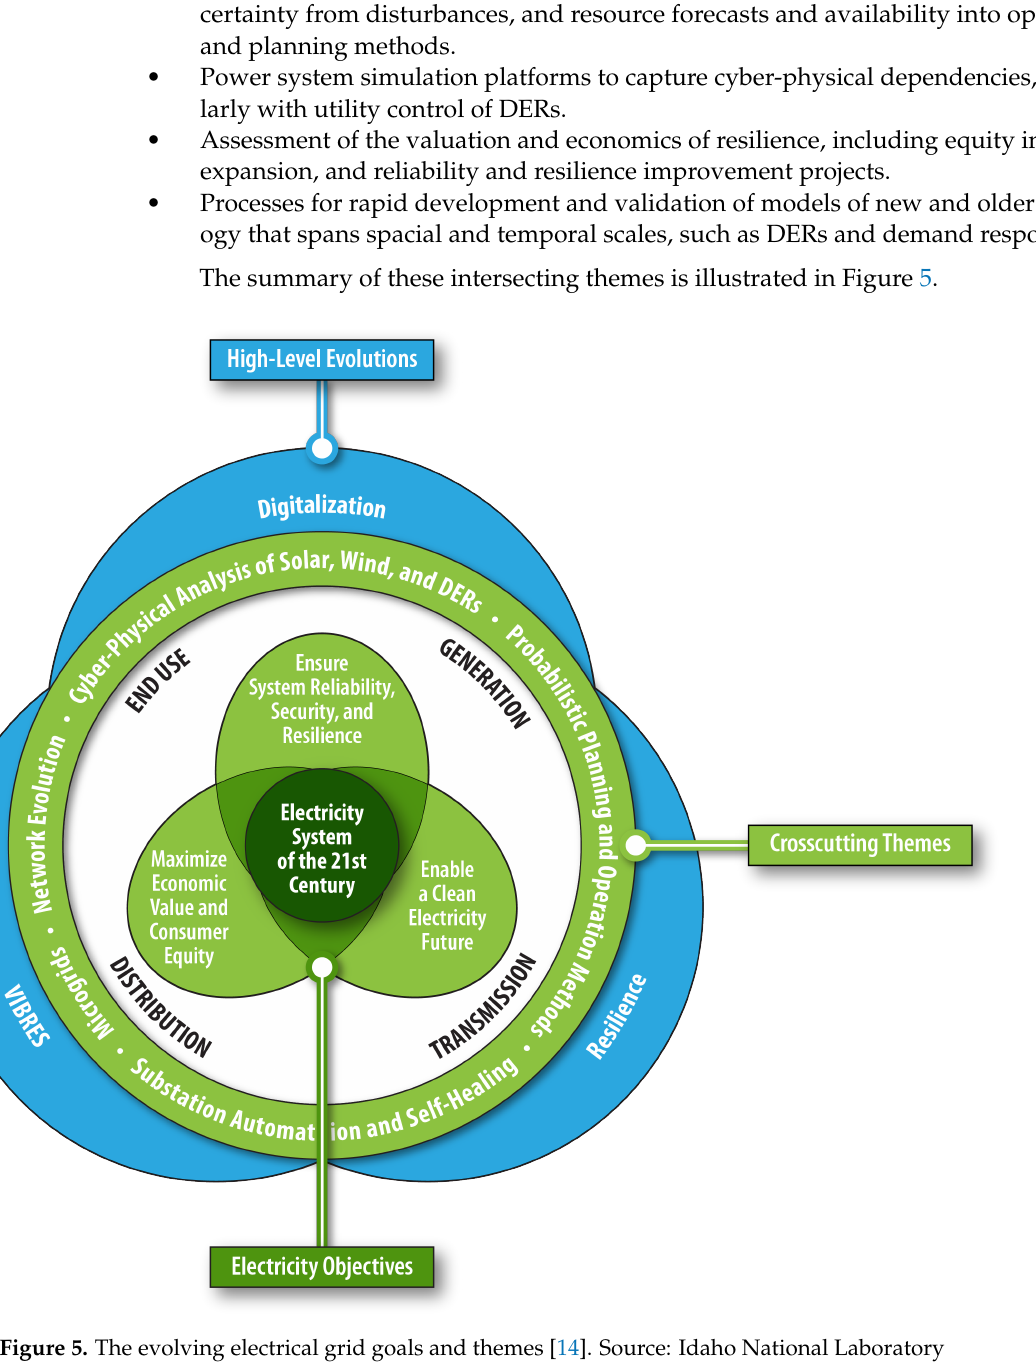
Figure 5. The evolving electrical grid goals and themes [14]. Source: Idaho National